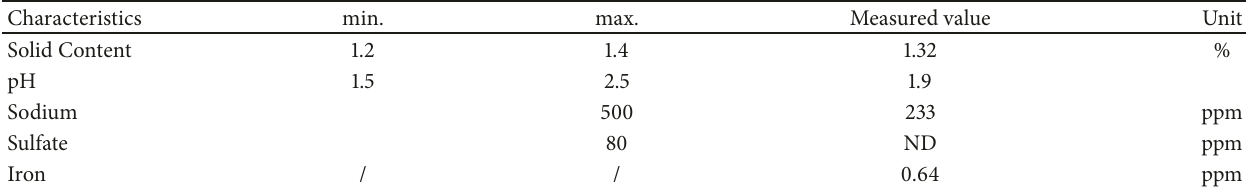
Table 1: Characteristics of Clevios P